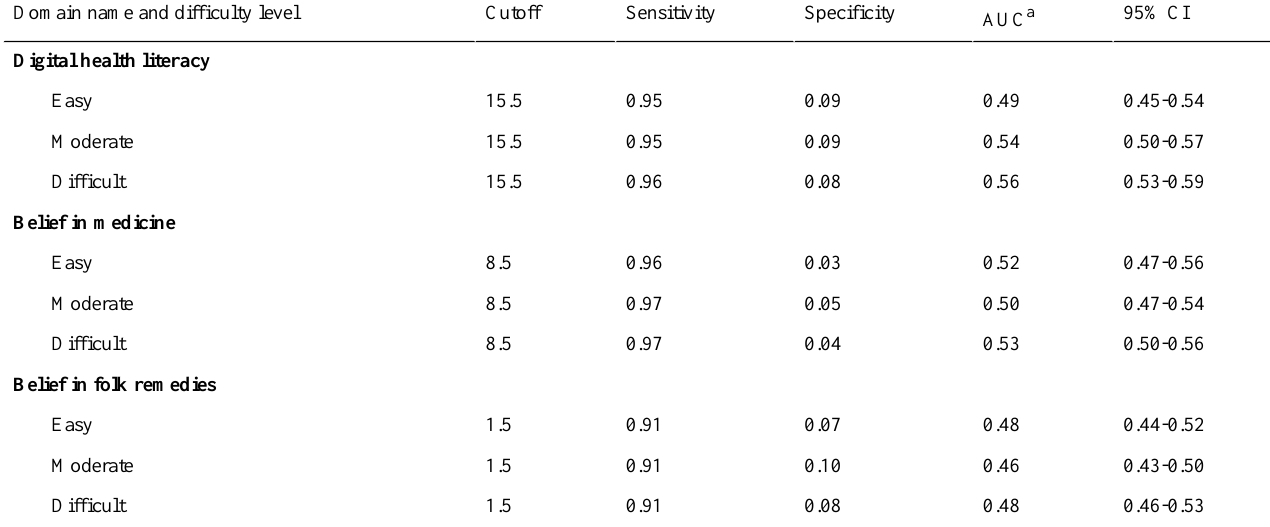
Table 3. Receiver operating characteristic curve analysis of the cutoff points of the digital health literacy assessment scores by accurate judgment and difficulty